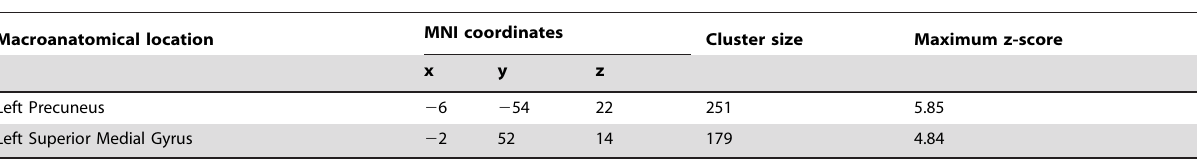
Table 6. Activation peaks of conjunction analysis of SOC > EMO > DMN.